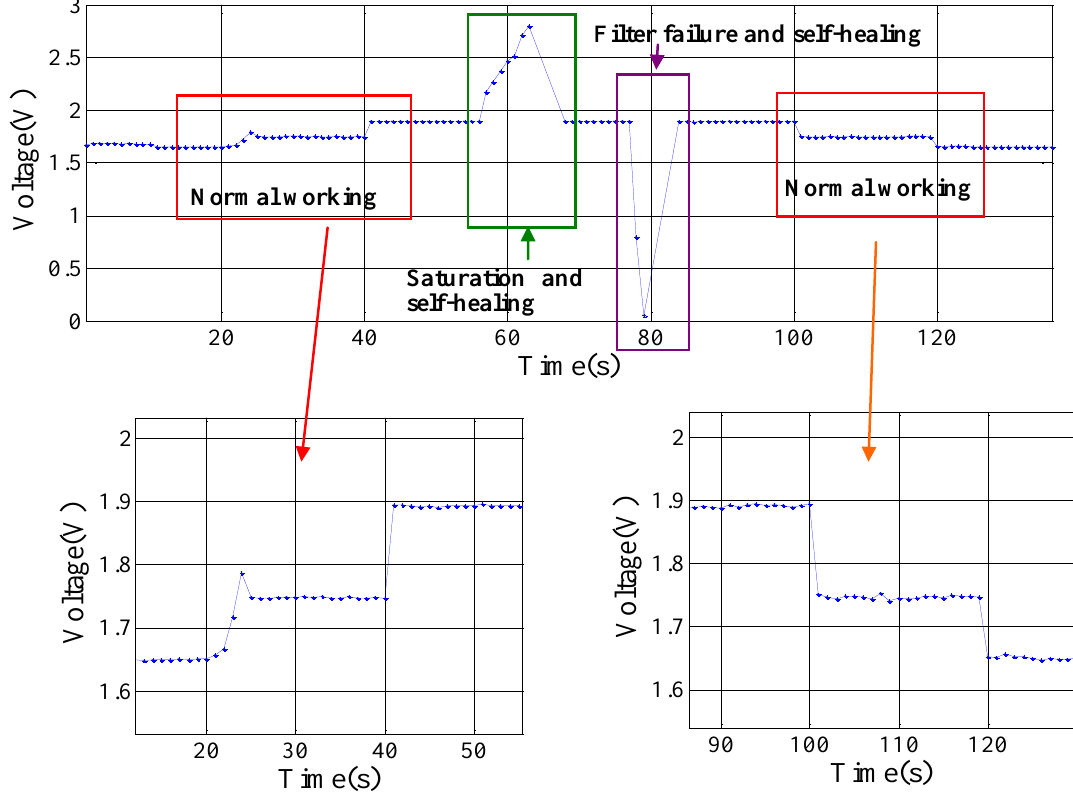
Figure 15. Output from the redundancy-based self-healing node during experiment.